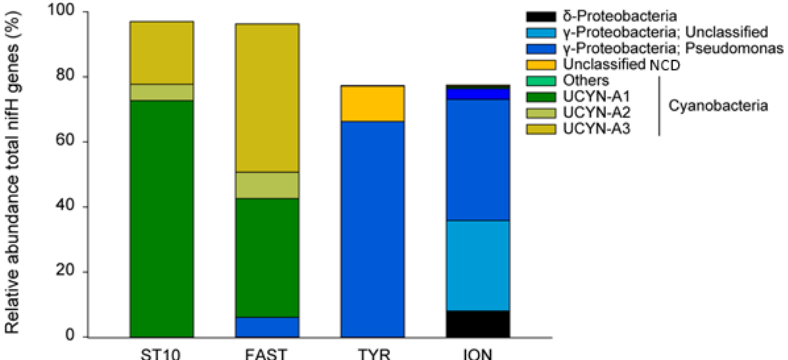
Figure 9. Relative abundance of the 20 most abundant nifH ASVs in surface waters (values at TYR, ION and FAST are based on average of duplicated control and dust treatments at